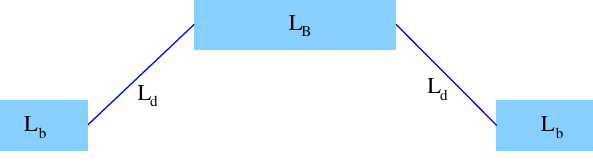
(cid:1) 0 : 3 m , L b B